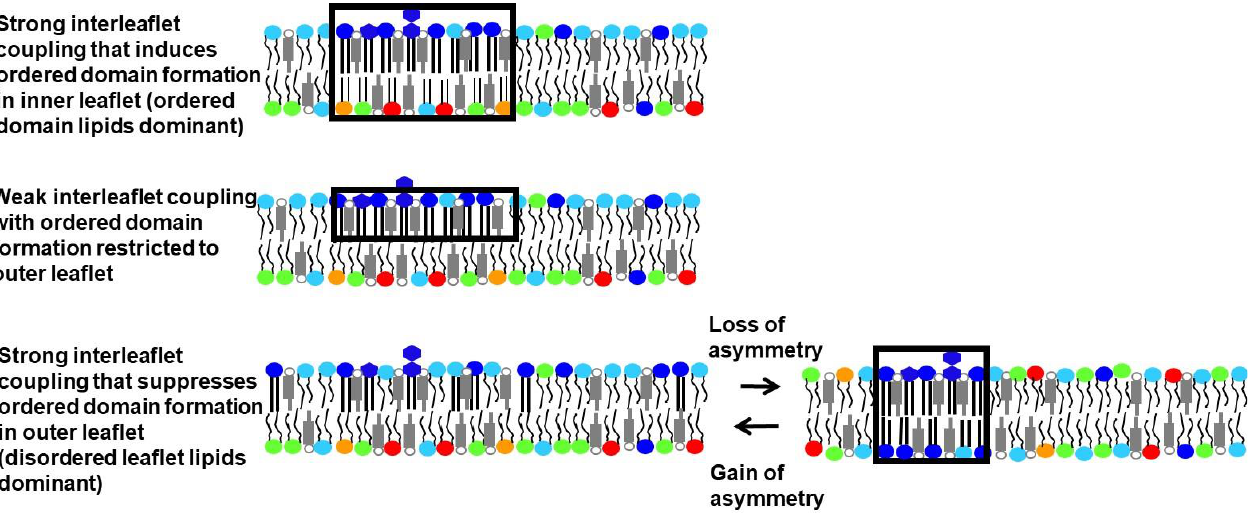
Figure 1. Some potential consequences of the loss or gain of lipid asymmetry for ordered domain formation. Ordered domains are shown by black boxes. Strong interleaflet coupling can either induce ( top ) or destroy ( bottom ) ordered domain formation in asymmetric membranes depending on whether the sphingolipid-rich or unsaturated lipid-rich leaflet dominates. In the latter case, loss of asymmetry ( bottom right ) can induce ordered domain formation. In the former case, loss of asymmetry can potentially inhibit domain formation (not shown). Dark blue, sphingolipid; light blue, PC; green, PE; red, PS; orange, PI; gray, cholesterol.